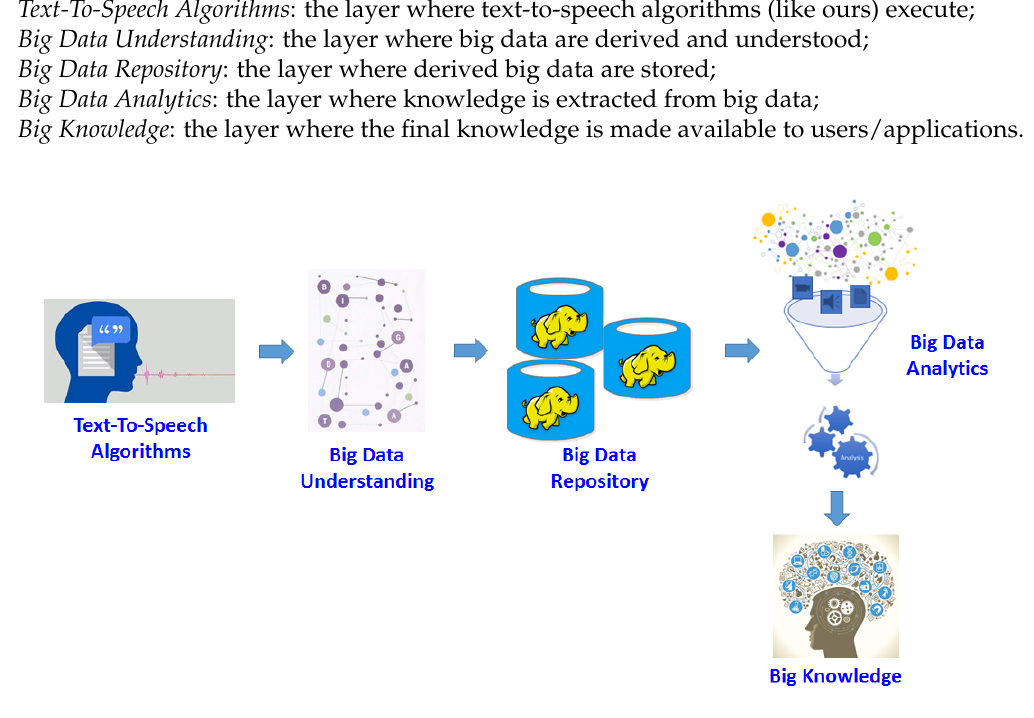
Figure 1. Human-machine interfaces and big data